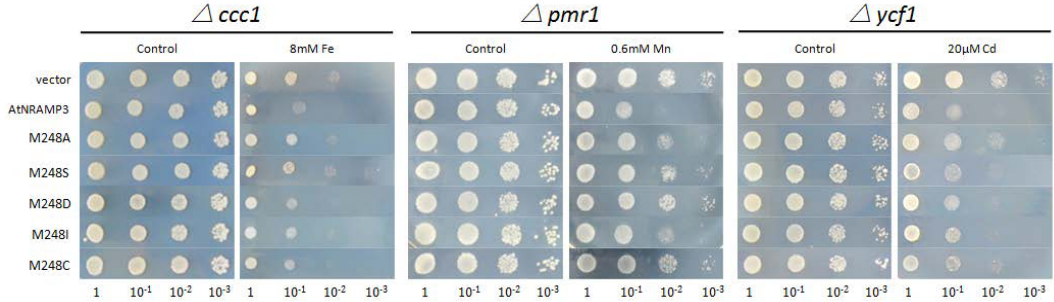
Figure 4. Met-248 mutations showed different phenotypes in yeast. Substitution of Met248 with Ala, Ser, Ile, Cys and Asp were transformed into S. cerevisiae mutants Δ ccc1 , Δ pmr1 and Δ ycf1 , respectively. Transformants were pre-cultured in SD-Ura overnight. Pre-cultured cells were diluted to an OD 600 of 1.0, 10 μL of each cell suspension was spotted onto selective SD-Ura plates with metal supplementation as indicated. The plates were incubated for 72 h at 30 °C.